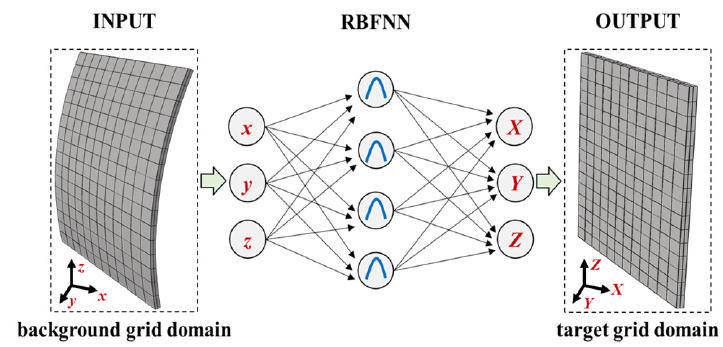
Figure 2. Schematic diagram of training RBF neural network.